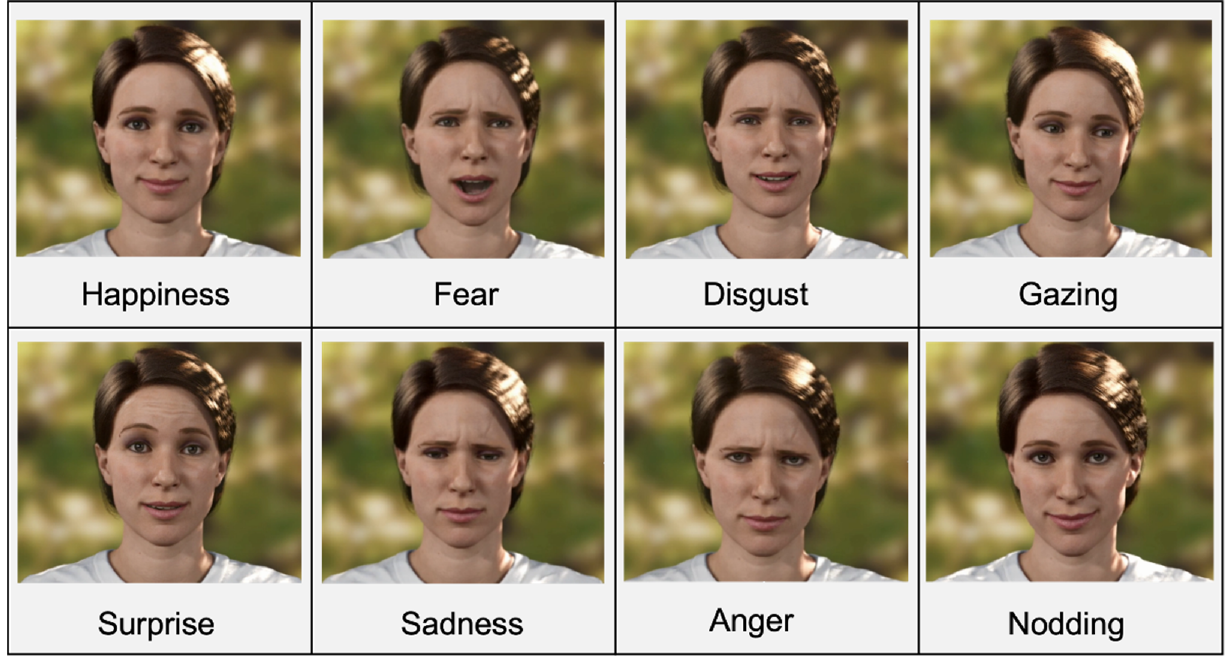
Figure 1. Various facial expressions displayed by the virtual agent, Truly: they include Ekman’s six basic emotions in addition to gazing and nodding.